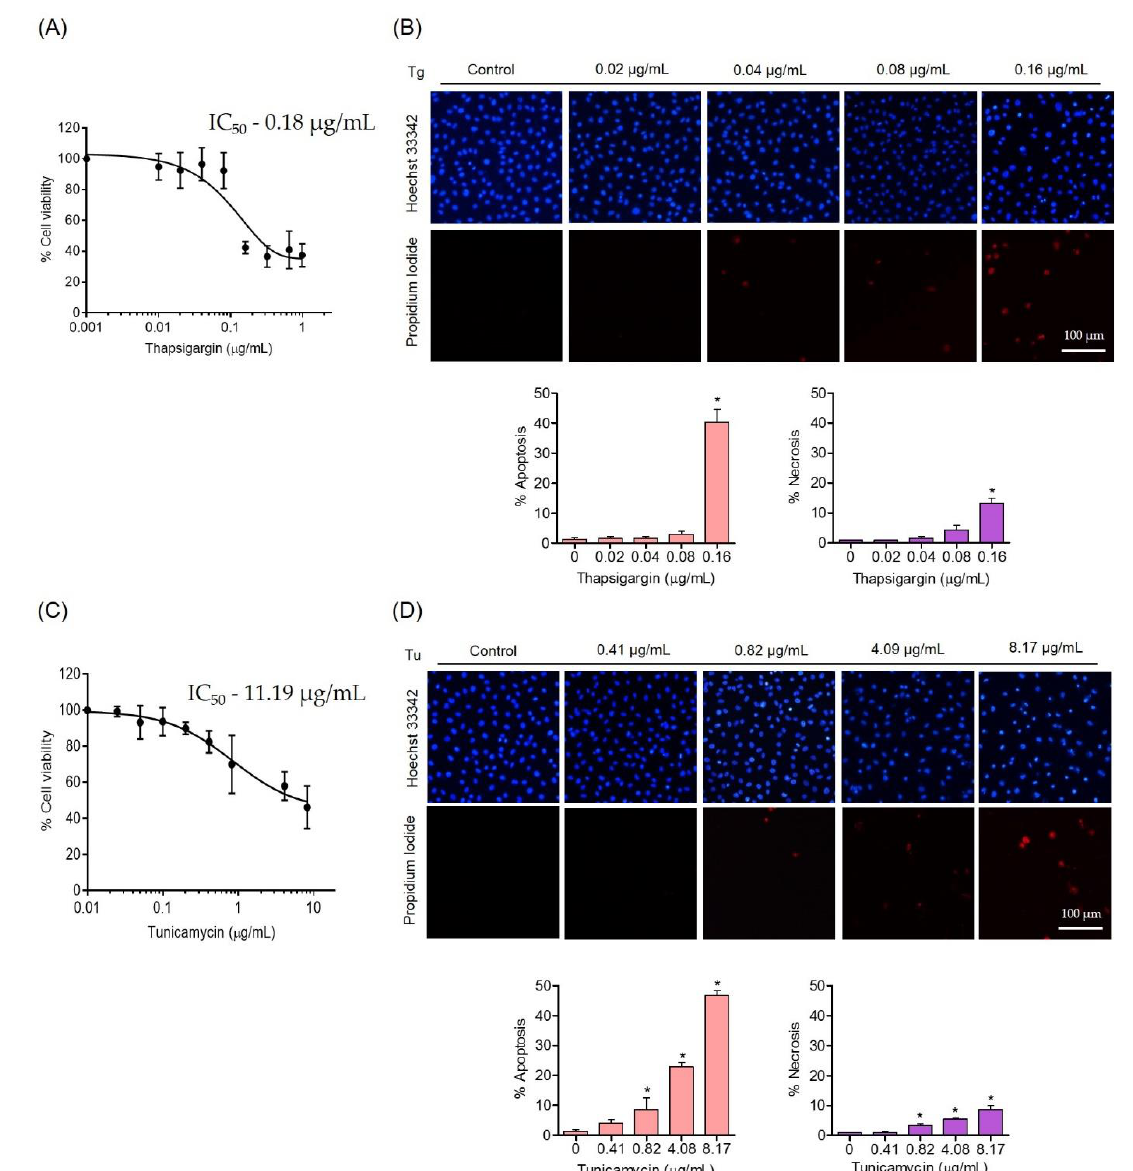
Figure 3. Cytotoxicity of ER stress inducers thapsigargin (Tg) and tunicamycin (Tu) on human endothelial cells. ( A , C ) Effect of ER stress inducers on the cell viability of EA.hy926 cells at 24 h evaluated by MTT assays. ( B , D ) Morphology of the apoptotic or necrotic nuclei evaluated by Hoechst 33342 and propidium iodide (PI) co-staining, visualized using fluorescence microscopy and calculated for the percentages of apoptosis and necrosis cells. Data are presented as mean ± SD ( n = 3). Significant compared with control group, * p < 0.05 versus the non-treated control.